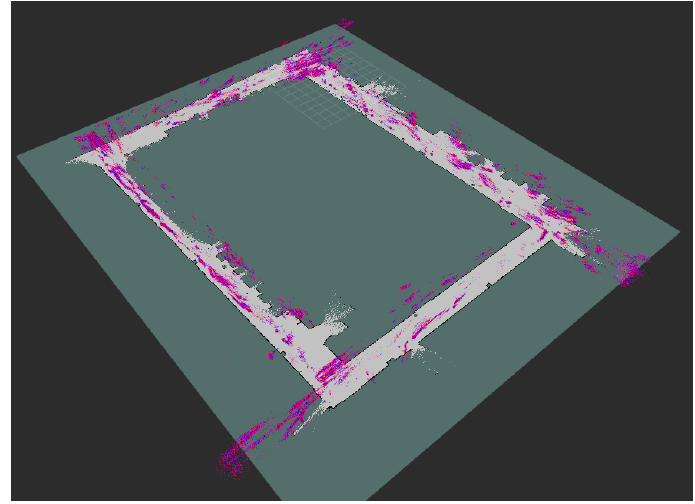
Figure 10. The result of the proposed method showing feature position and grid map.